Question: What caption would you write for this figure?
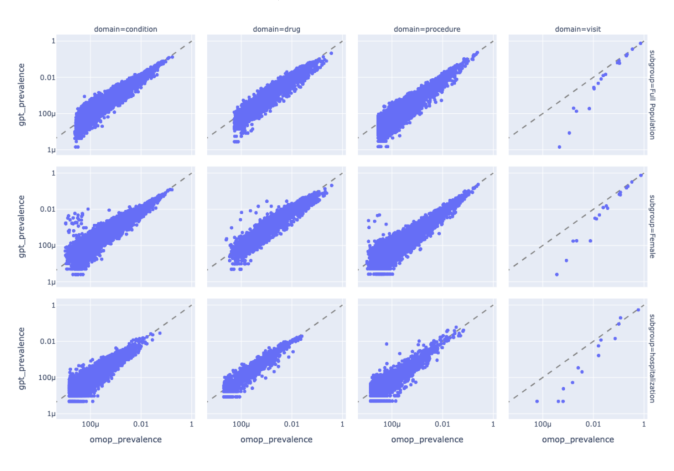
Answer: Concept prevalence comparison between the source OMOP and generated OMOP using top p = 95% in the log scale stratified by domain in columns and by population in rows, where x-axis and y-axis represent the source and the synthetic data re- spectively, and each dot represents a concept